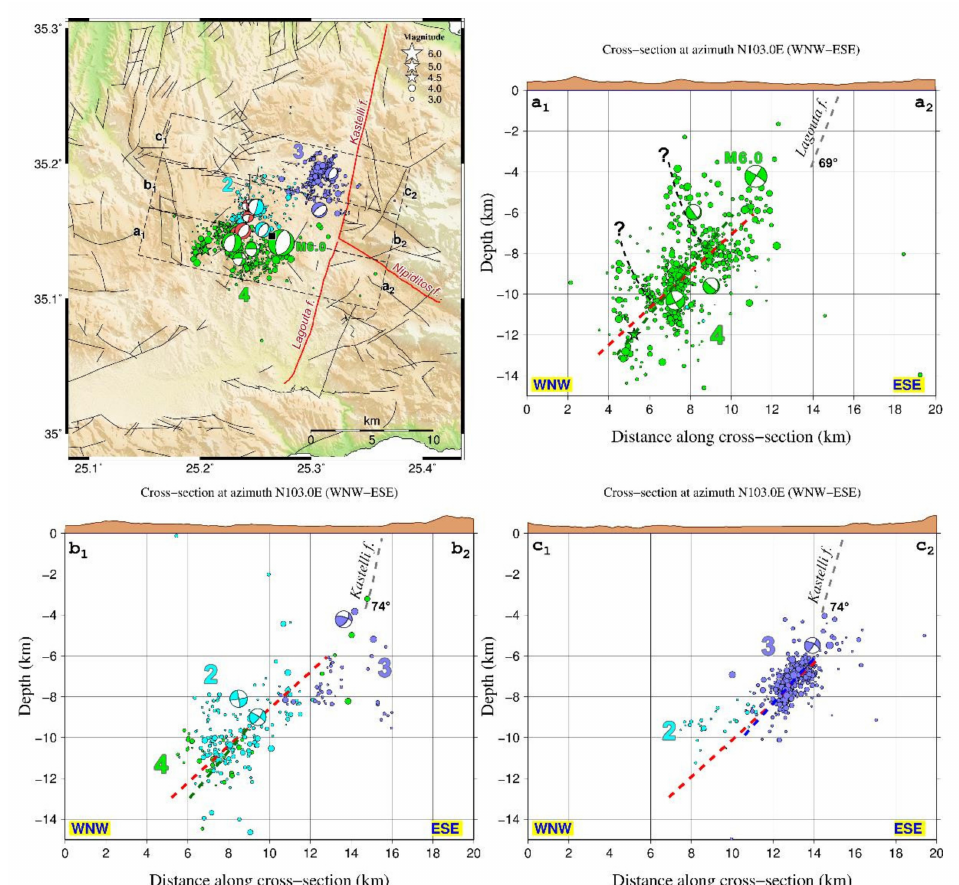
Figure 10. Map and cross-sections of the relocated 2021 Arkalochori aftershock sequence (period 27 September–18 October 2021). Colors and numbers correspond to the aftershock spatial groups 2–4 presented in Figure 7b. The cross-section profiles are drawn in an N103 ◦ E direction, roughly perpendicular to the strike of the mapped Kastelli and Lagouta faults, whose downdip extension is presented in the cross-sections with gray-dashed lines. The red dashed line is the section of the least-squares plane fitted to the relocated hypocenters of period B, whereas the green ( a 1 – a 2 , b 1 – b 2 ) and blue ( c 1 – c 2 ) dashed lines are the planes fitted to groups #2 and #4 (green), and group #3 (blue), respectively. The possible antithetic structures are marked with black-dashed lines ( a 1 – a 2 ). Focal mechanisms of the mainshocks and other major events of the sequence, including foreshocks (red beachballs, on the map only) are from the database of GI-NOA. The location of Arkalochori village is marked with a black square on the